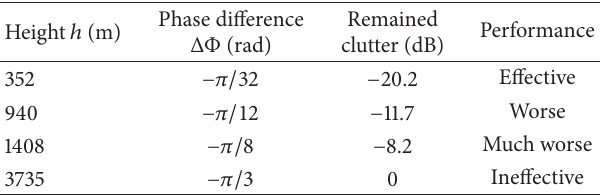
Table 1: Phase difference in the terrain with different